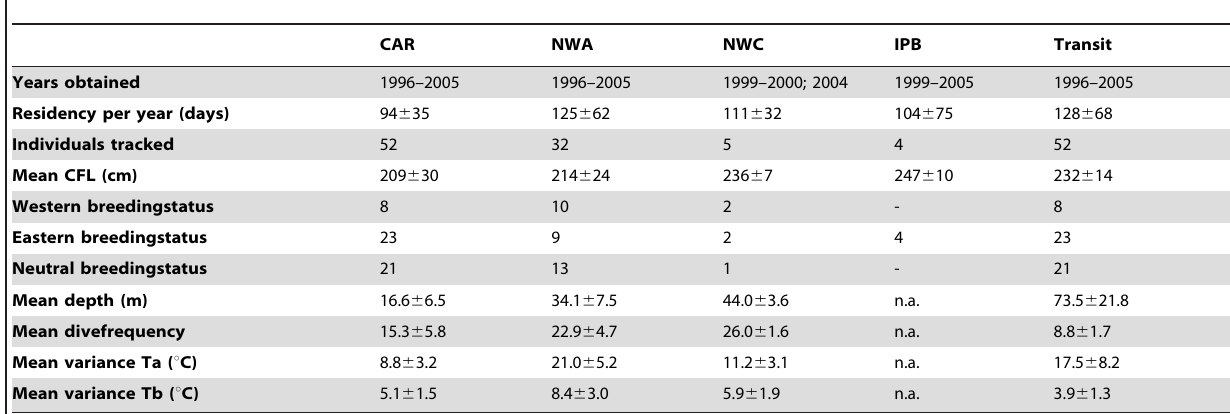
Table 3. Summary of residency and composition of tracked ABFT as well as diving and temperature indexes within particular high use area and non-high use areas (1996–2005, mean 6